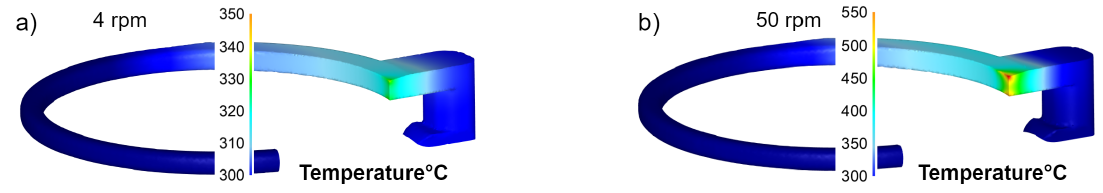
Figure 11. Temperature level in the extrusion grip zone. ( a ) rotational speed 4 RPM; ( b ) rotational speed 50 RPM.